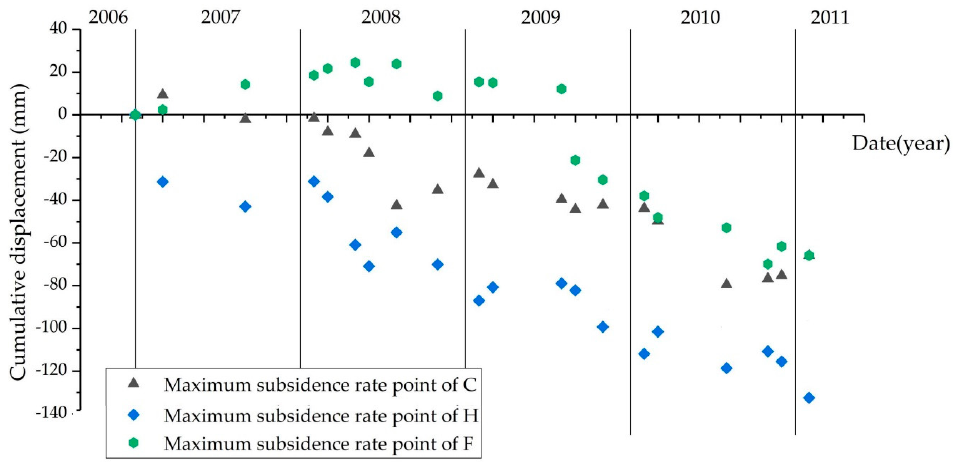
Figure 13. Cumulative displacement for small and medium-scale mines estimated by SBAS-InSAR technique from 2006 to 2011.